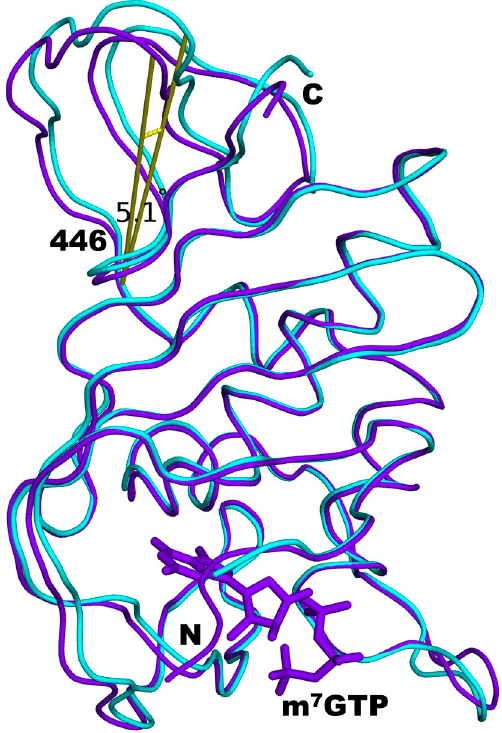
Figure 4. Using only the coordinates from the N-subdomain, 5WOP Chain A (cyan) was superimposed with 5EG7 (purple). The yellow line represents a 5.1° rotation of the C-terminal subdomain [10,26].